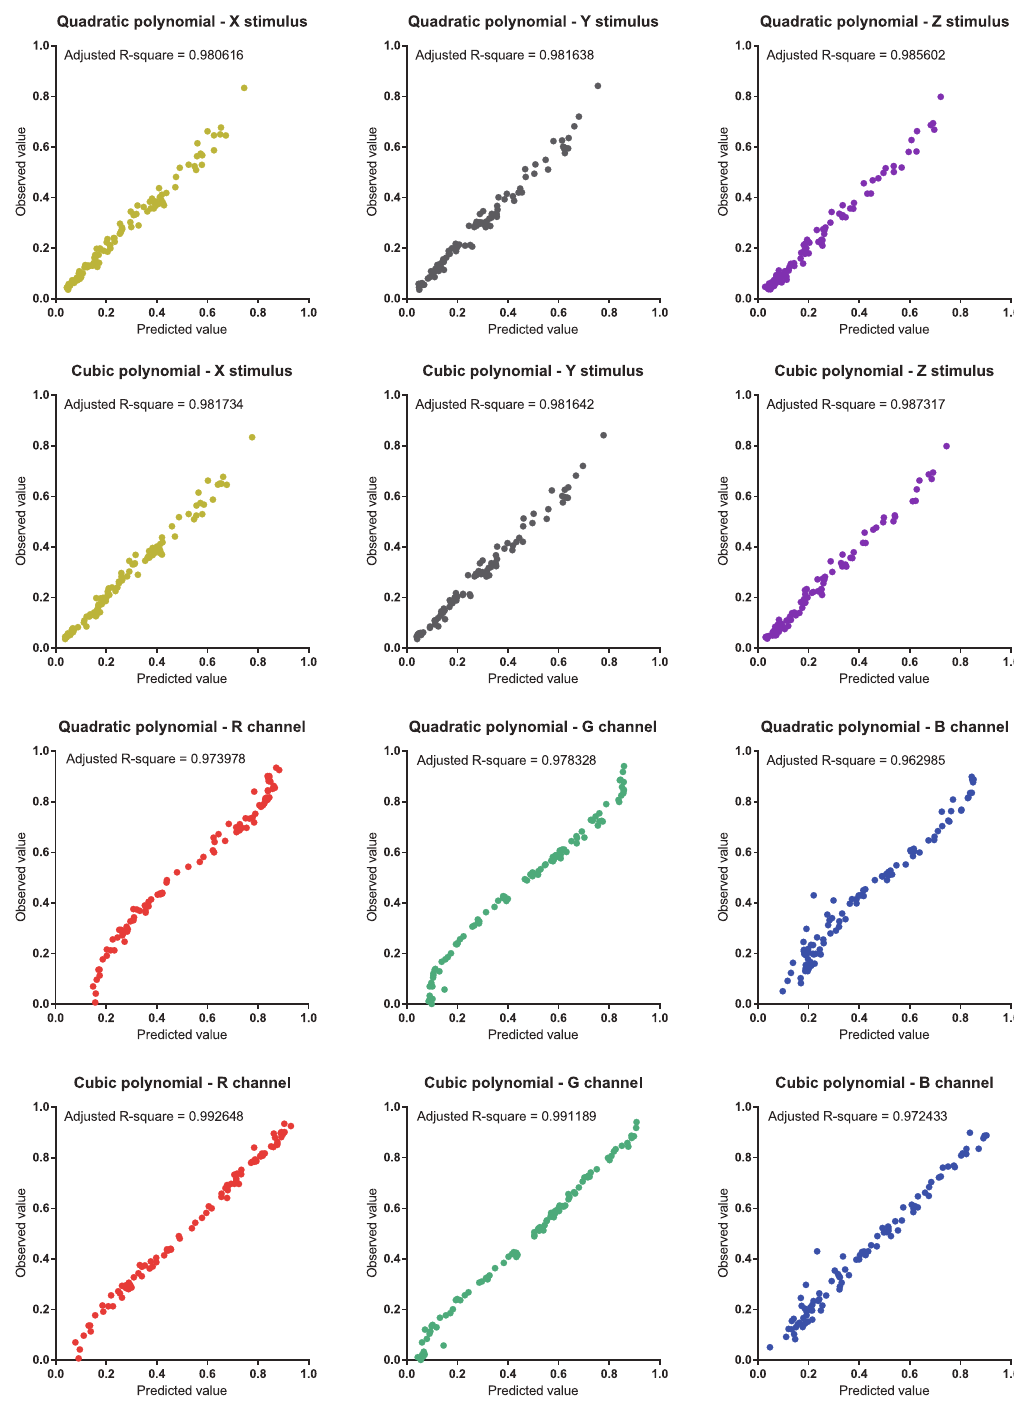
Figure 7. Scatter plots of predicted and observed values for colour profiles. Having more points closer to the diagonal indicates better